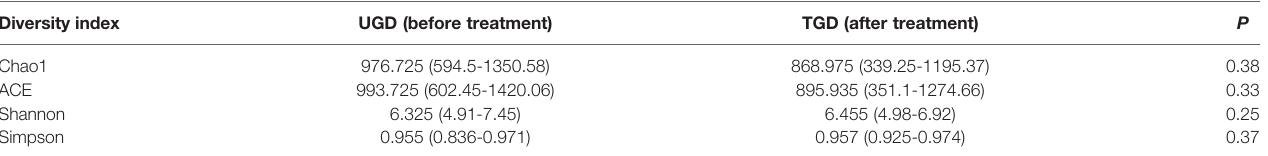
TABLE 2 | The diversity indexes of GD patients before and after treatment. Diversity